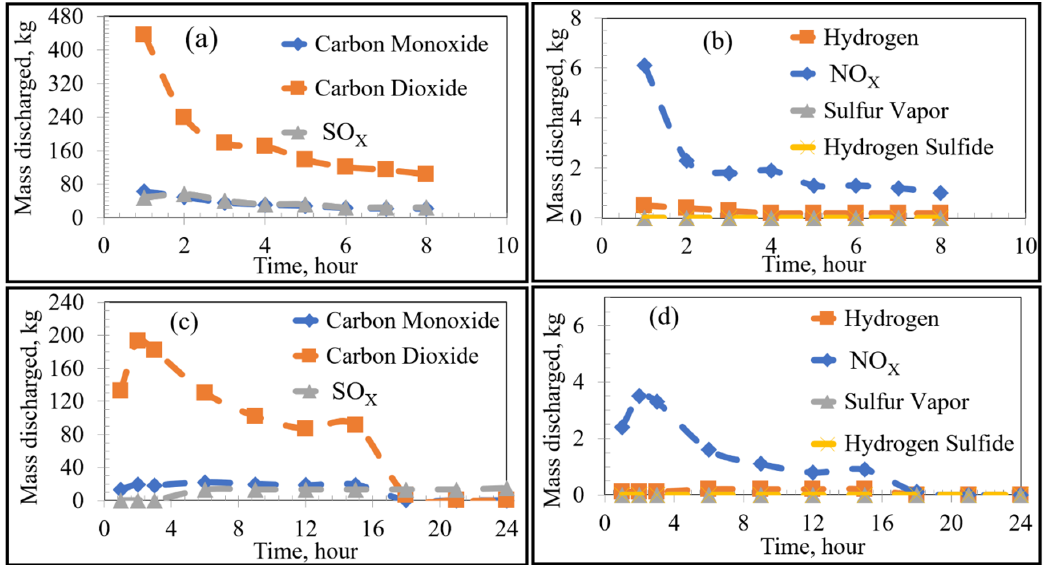
Figure 5. Emissions under stoichiometric combustion as a function of time: Low Sulfur Emission Case; ( a ) and ( b ) show the Current Operation and ( c ) and ( d ) show the Future Operation.